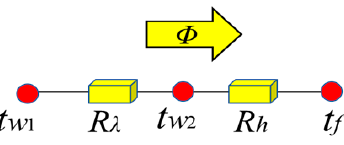
Figure 3. Thermal resistance network.